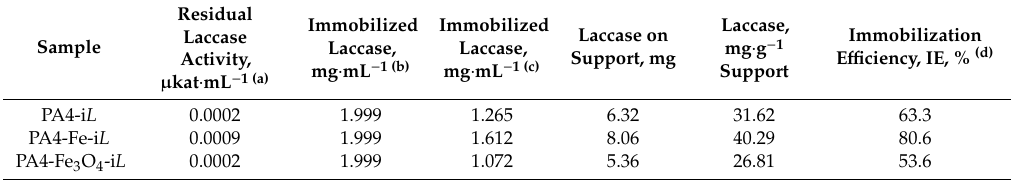
Table 3. Enzyme quantification in the PA4@iL